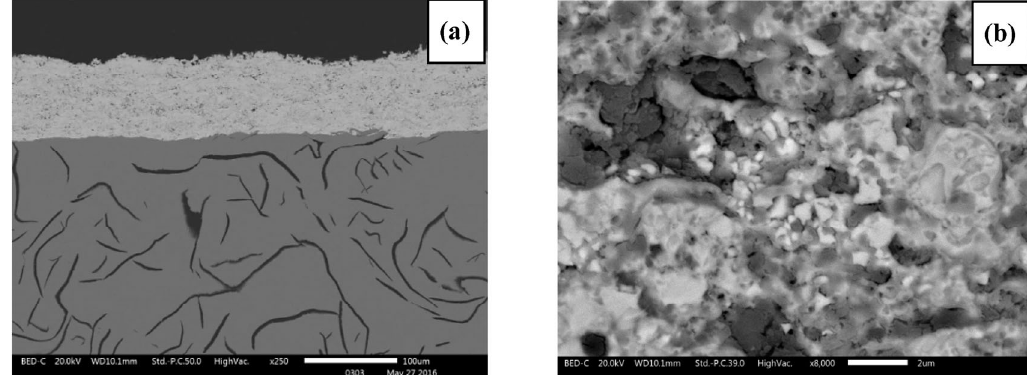
Fig. 2 SEM micrographs showing the cross-section of the BD2 disc at two different magnifications:(a) general view of the WC-CoCr coating, (b) microstructure of the coating. The brighter particles are the tungsten carbide grains.